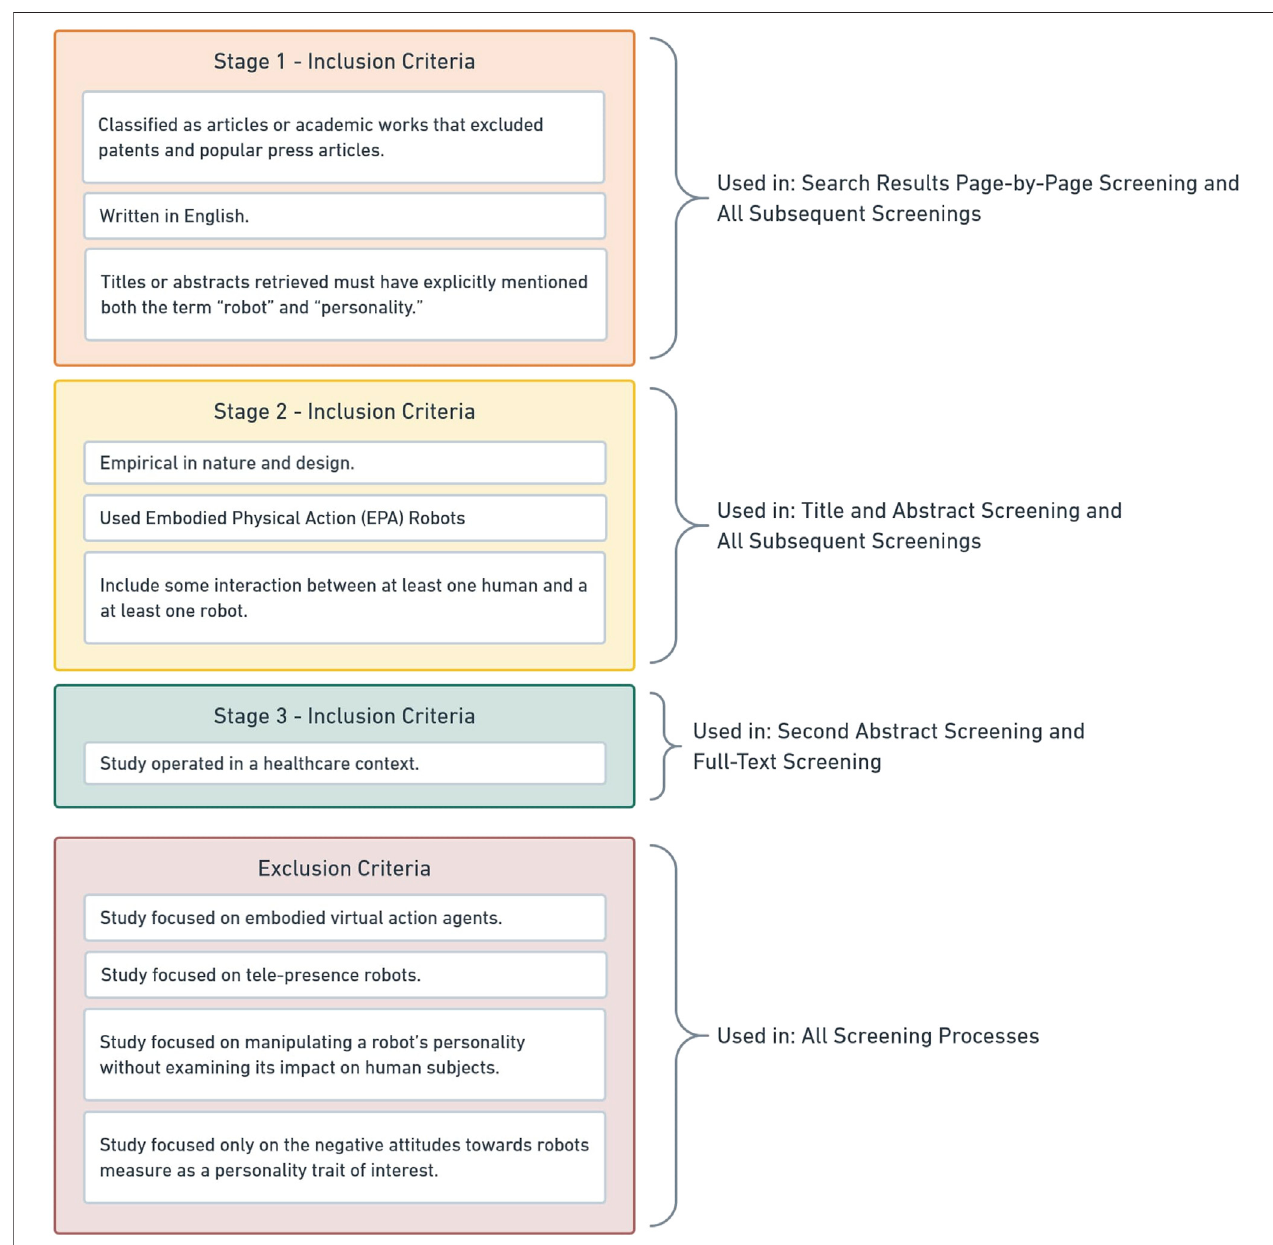
FIGURE 1 | A summary of our screening criteria presented in a visual and format.